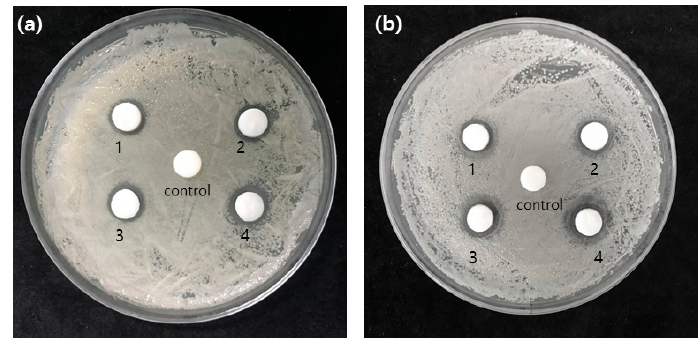
Figure 4. Inhibition zone test result ( a ) S. mutans group (1: 50 μ g/mL, 2: 100 μ g/mL, 3: 150 μ g/mL, 4: 200 μ g/mL) ( b ) C. albicans group (1: 50 μ g/mL, 2: 100 μ g/mL, 3: 150 μ g/mL, 4: 200 μ g/mL).